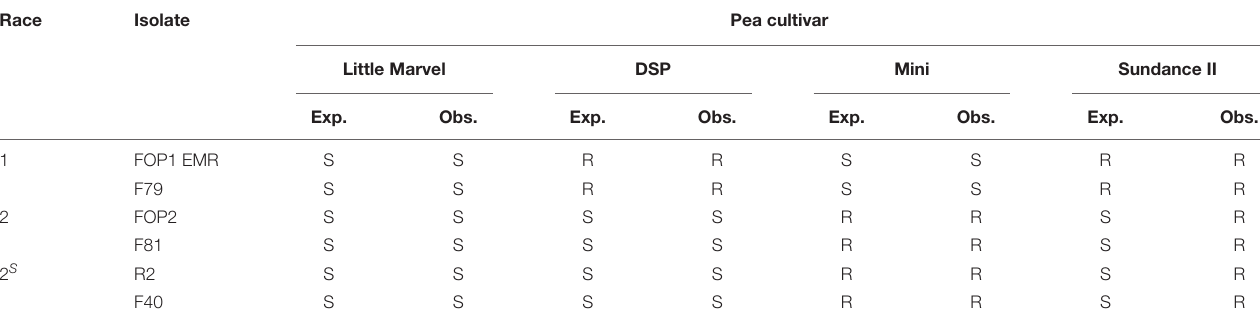
TABLE 2 | Summary of expected (Exp.) and observed (Obs.) results for the resistance and susceptibility of pea differential cultivars to different FOP isolates representing preliminary races 1, 2, and 2 S as designated based on SIX gene complement. Race Isolate Pea cultivar Little Marvel DSP Mini Sundance